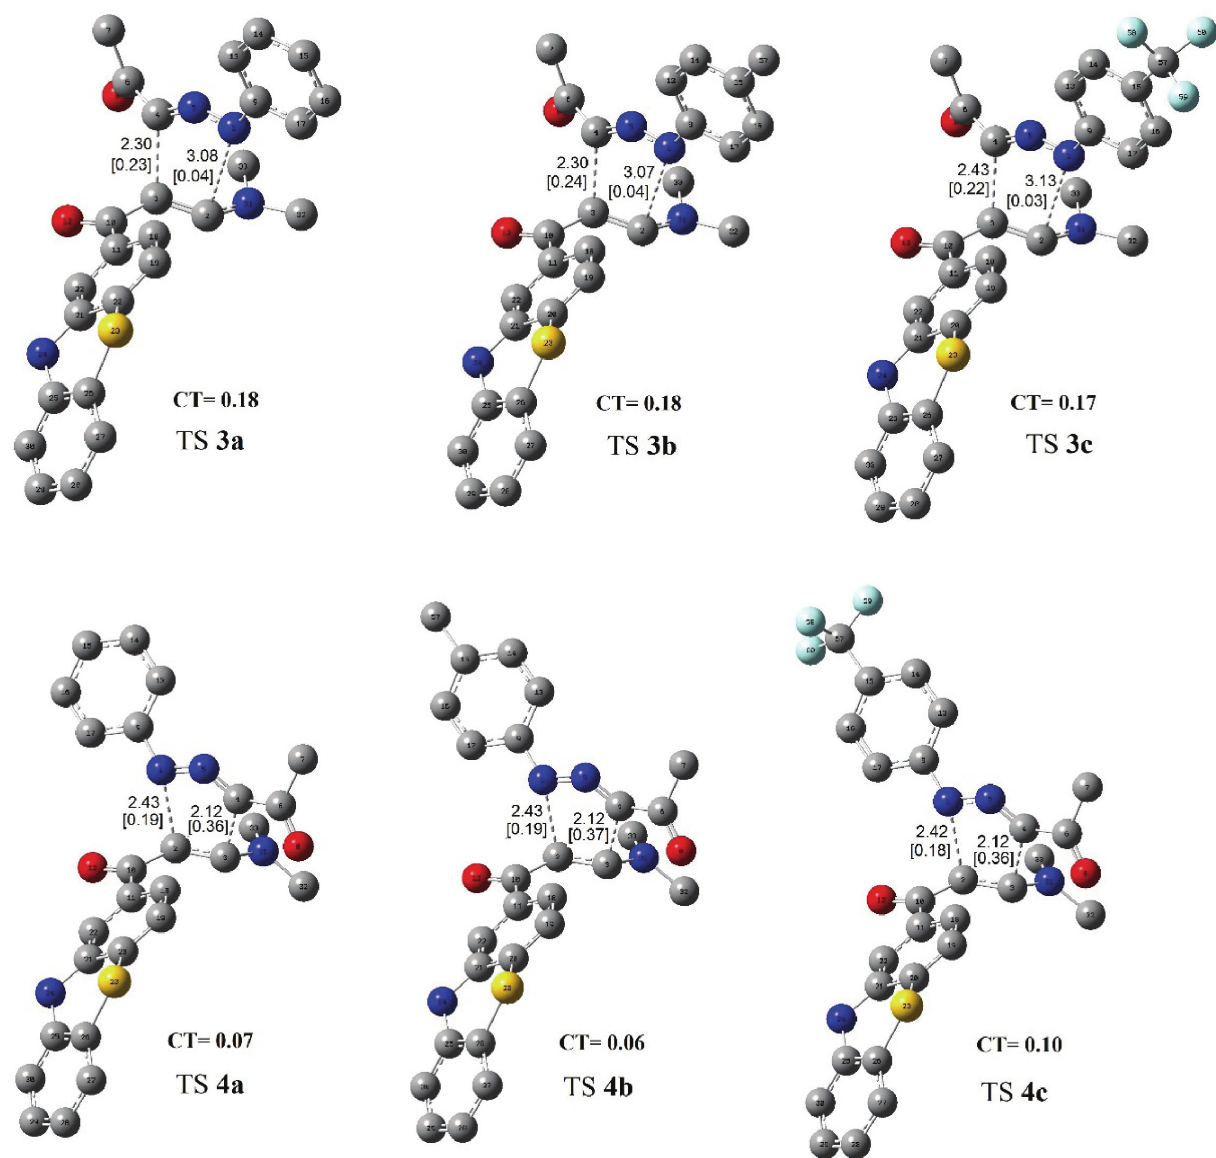
Figure1 . The optimized geometries for transition state structures at the B3LYP/6-311G (d,p) level of theory. Hydrogen atoms have been omitted for clarity. Distances of forming bonds are given in angstroms. The bond orders are given in brackets.